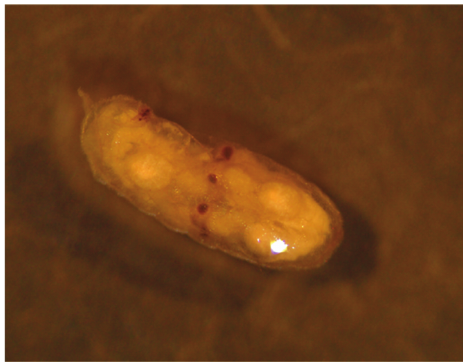
Figure 3: Larva of the neotropical weaver ant Camponotus sp. ca. textor parasitized by the gregarious endoparasitoid Horismenus myrmecophagus (Eulophidae). Several wasp larvae can be observed through the host cuticle. Photo: G.